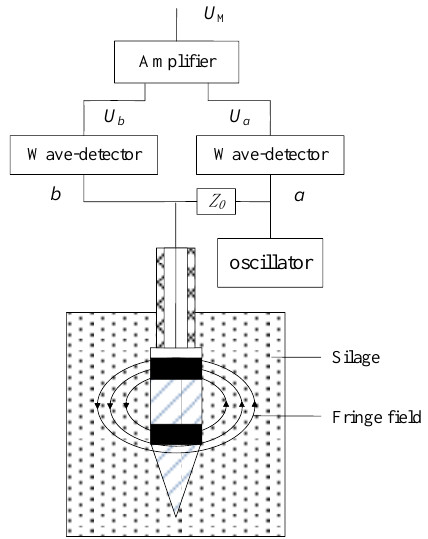
Figure 4. Schematic diagram of the compound sensor for moisture content measurement.